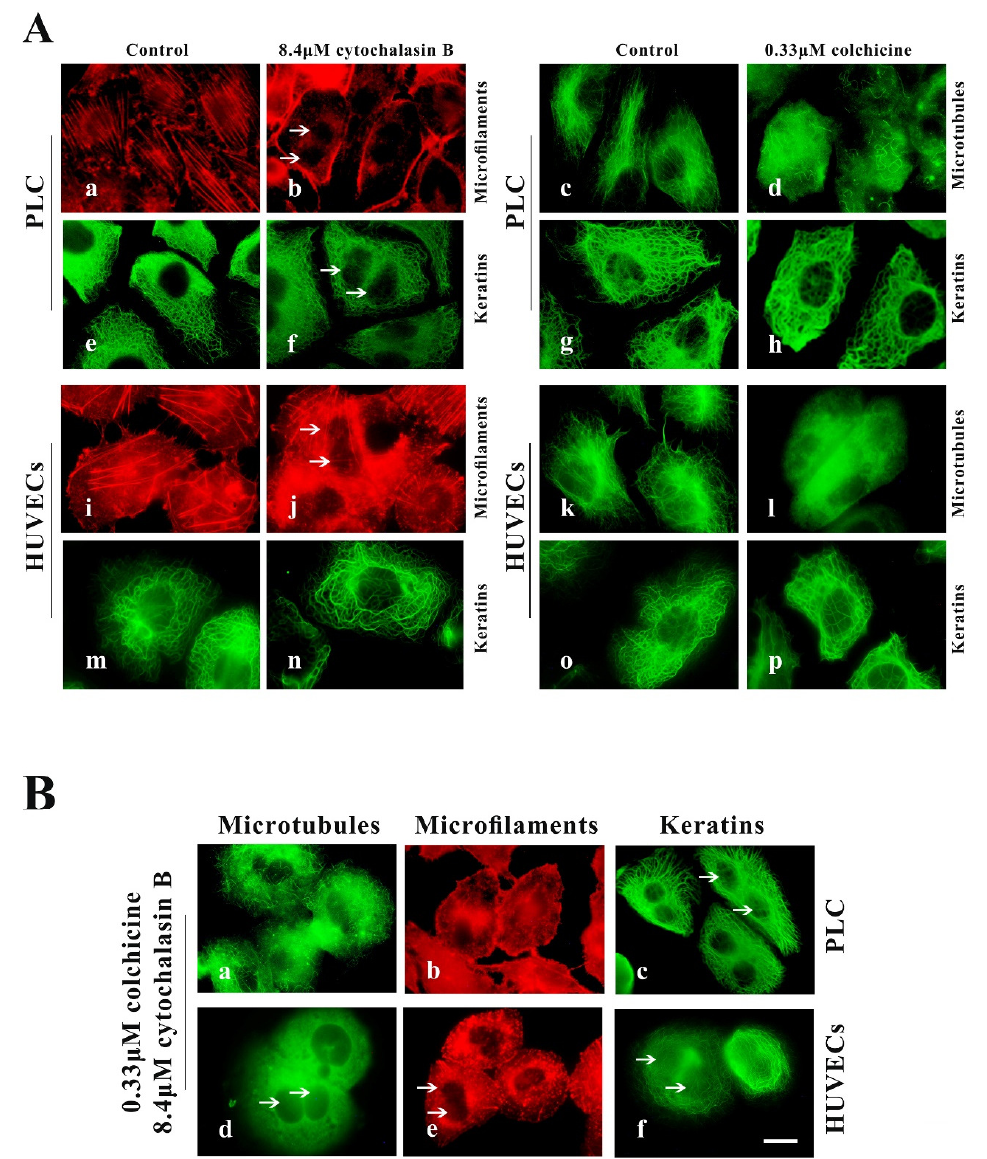
Figure 2. Cytochalasin B and colchicine cause the depolymerization of microfilament (MFs) and microtubules (MTs), respectively, in well-spread PLC and HUVECs but do not distinctly alter the keratin filament (KF) network. ( A ) Representative images of cell morphology and three cytoskeleton components in well-spread PLC and HUVECs treated with cytochalasin B (b,j,f,n) or colchicine (d,l,h,p) or DMSO (control, a,i,e,m,c,g,k,j,o). 1000 × , Bar, 10 µ m. ( B ) Representative images of cell morphology and three cytoskeleton components in well-spread PLC (a,b,c) and HUVECs (d,e,f) treated with cytochalasin B and colchicine. 1000 × , Bar, 10 µ m. The binucleate cells caused by cytochalasin B are indicated by arrows. Images represent typical cells from at least three independent experiments.